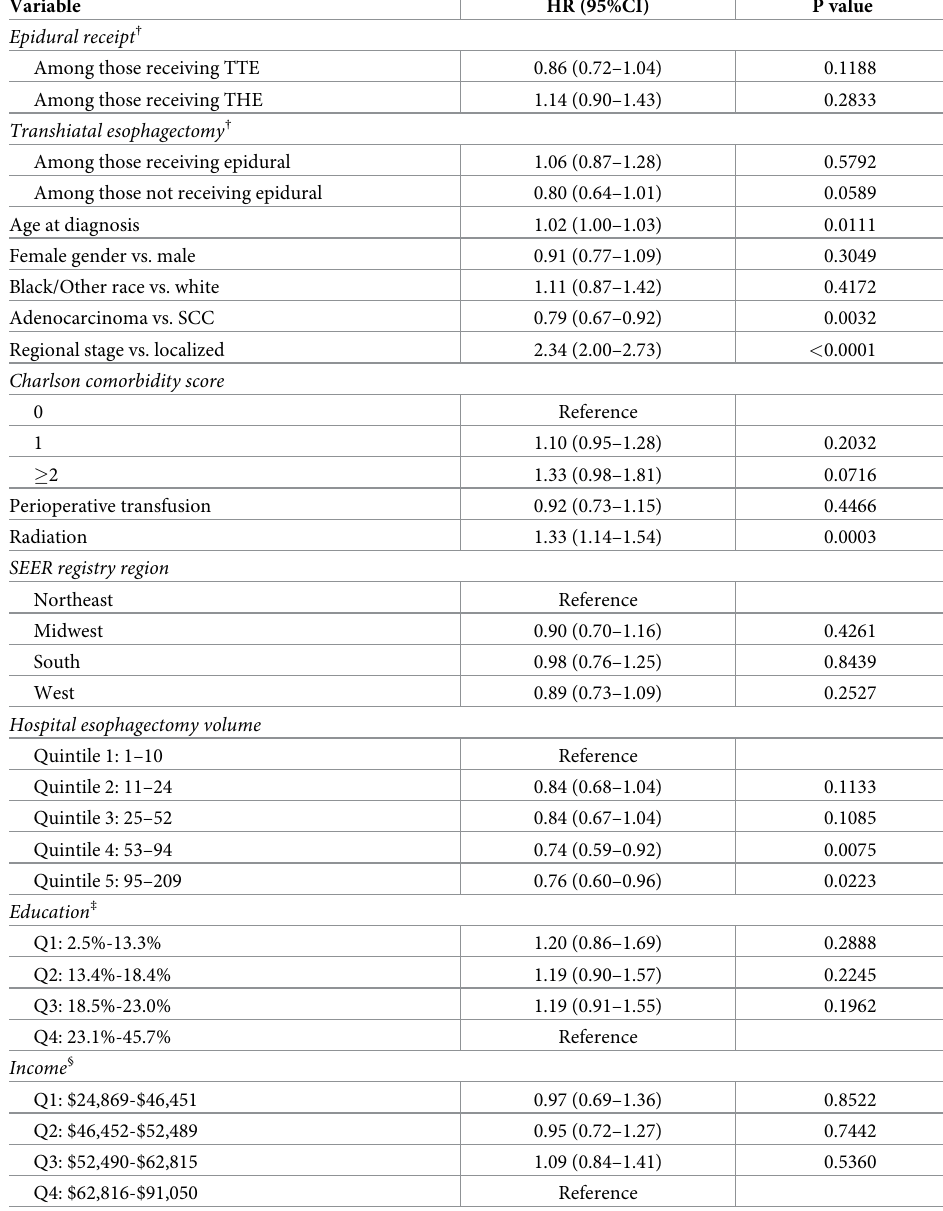
Table 3. Marginal Cox model for time to